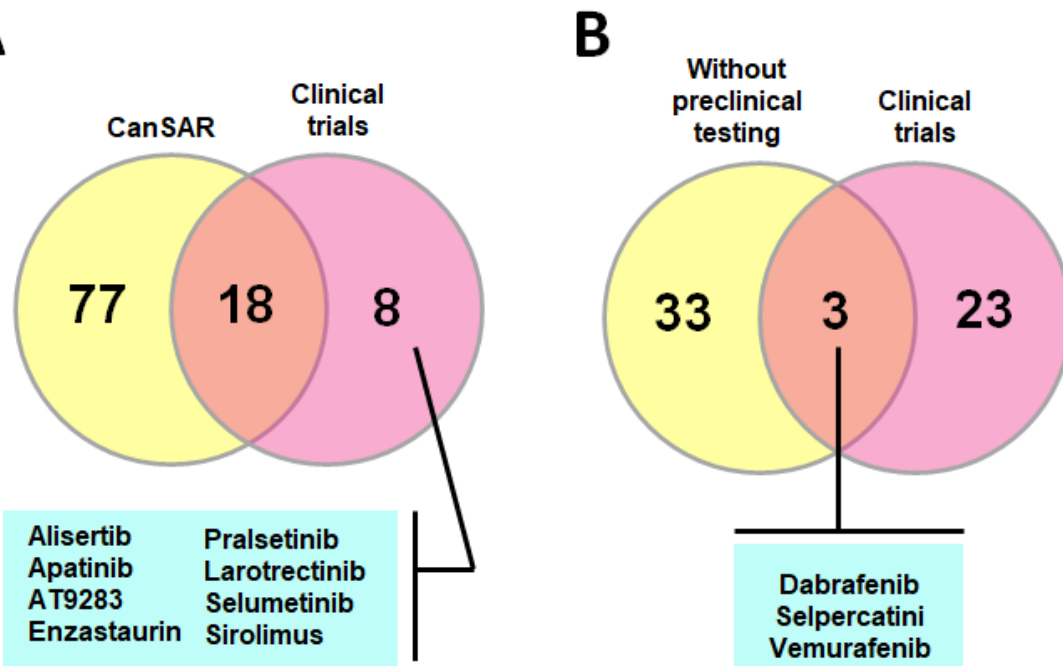
Figure 6. ( A ) Venn diagram showing the number of kinase inhibitors retrieved from the CanSAR platform versus those already tested in clinical trials. Around 30% of the compounds have been tested in patients. Of note, eight kinase inhibitors tested in clinical trials were not found in the CanSAR platform. ( B ) Venn diagram comparing kinase inhibitors found in the CanSAR platform without evidence of preclinical tests in pediatric cancer versus clinical trials. Three of the drugs are already tested in pediatric patients, without in vitro or in vivo evidence.